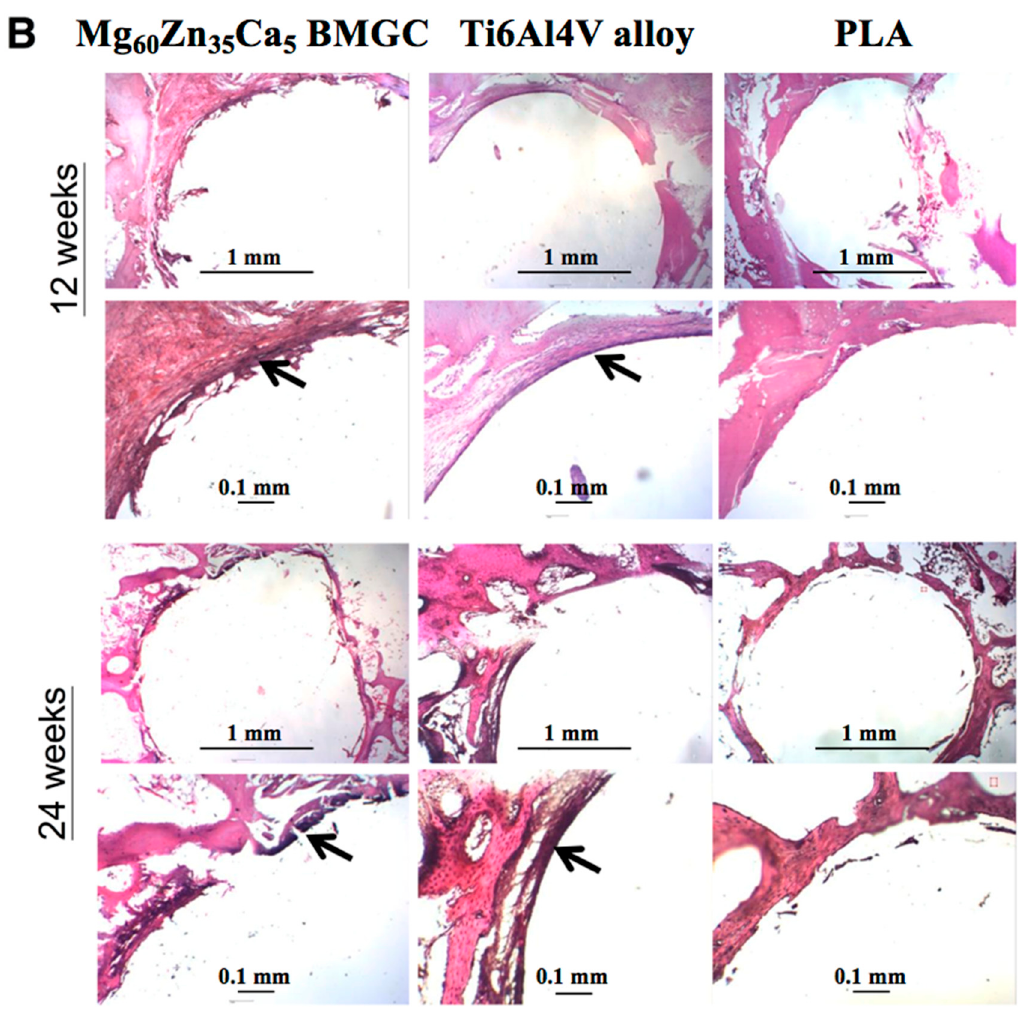
Figure 8. ( A ) Gross image of harvested rabbit femur indicating the surgical implanted site. The fixation rod was first removed before sent for histologic section. ( B ) Histological images of the implanted site at 12 weeks and 24 weeks. Black arrows indicate new bone formation. (Hematoxylin and eosin staining, upper panel 10×, lower panel